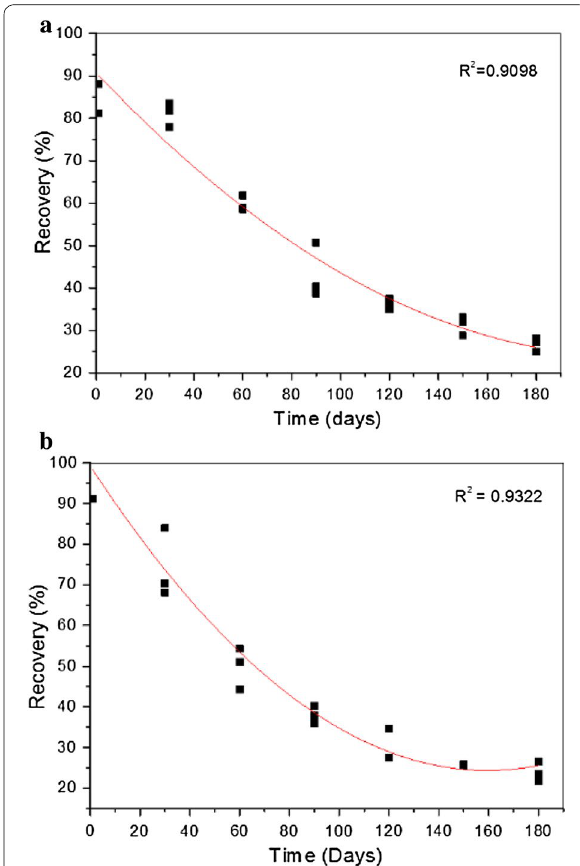
Fig. 5 Long-term stability test for rhynchophorol adsorbed on Na- magadiite ( a ) and zeolite L ( b